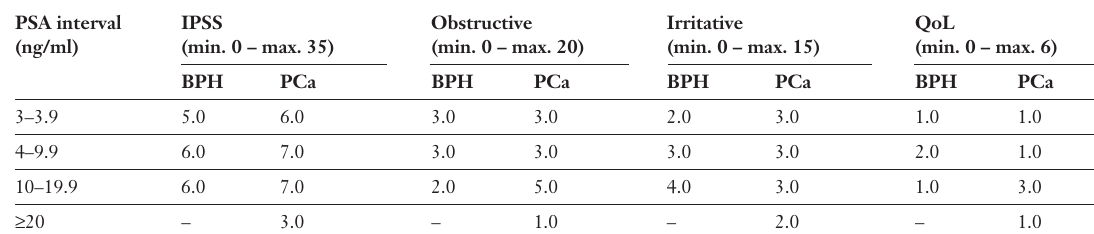
Micturition/QoL International Prostate Symptom Score (IPSS) parameter for BPH vs. PCa cases according to PSA